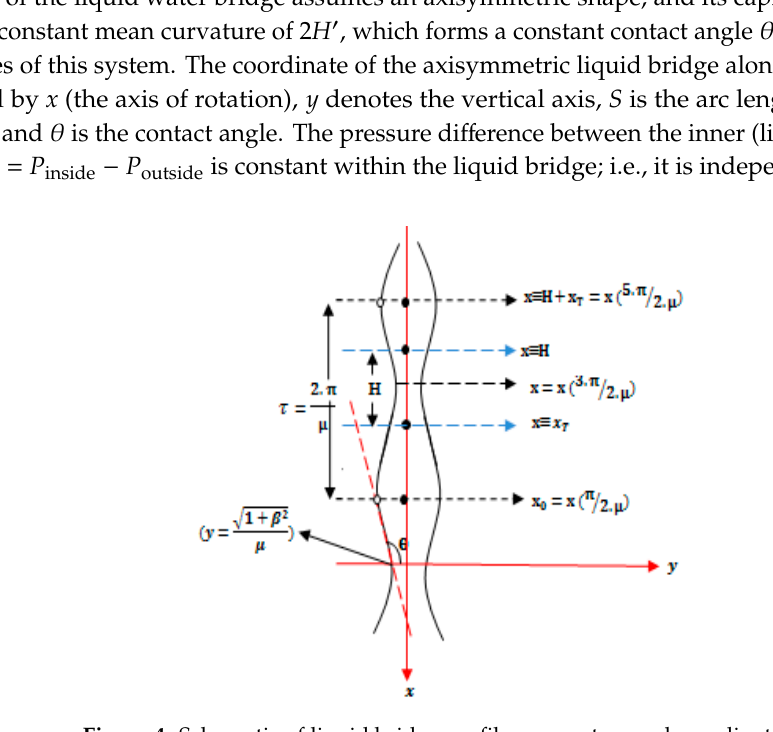
Figure 5. Schematic of a capillary bridge and geometric parameters. The liquid bridge density is ρ w , the viscosity is μ w , and the surface tension associated with the interface is 𝜎 . The density and viscosity of the surrounding air are negligible compared to water and do not affect the dynamics of the liquid bridge. In the absence of gravity effects (the Bond number B ≈ 0 (10 − 4 )), the equilibrium surface is a surface of constant mean curvature, and for the axisymmetric case, the bridge can have a cylindrical, spherical, catenoidal, unduloidal, or nodoidal shape. These properties are uniform and constant under isothermal conditions. When viscous and body forces are